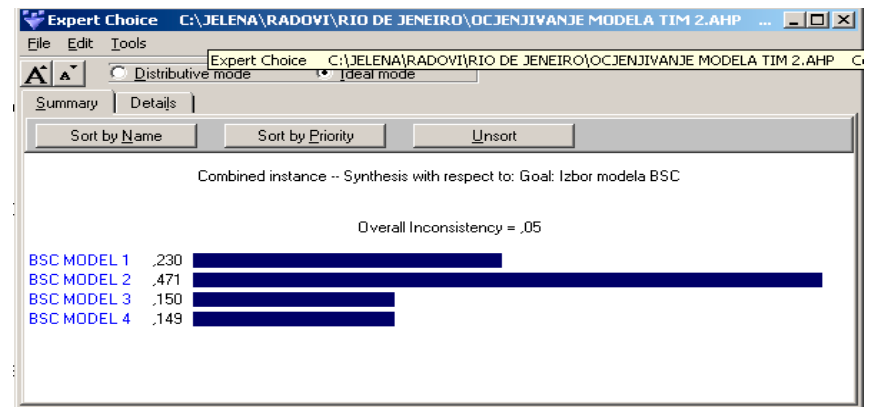
Figure 7. Results of evaluation of the BSC models obtained by Team 1 using the AHP method.